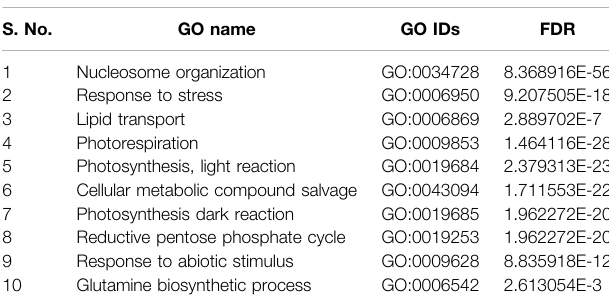
TABLE 6 | List of top 10 biological processes with GO IDs that are overrepresented in upregulated DEGs in shoot tissues of PBW703. S.